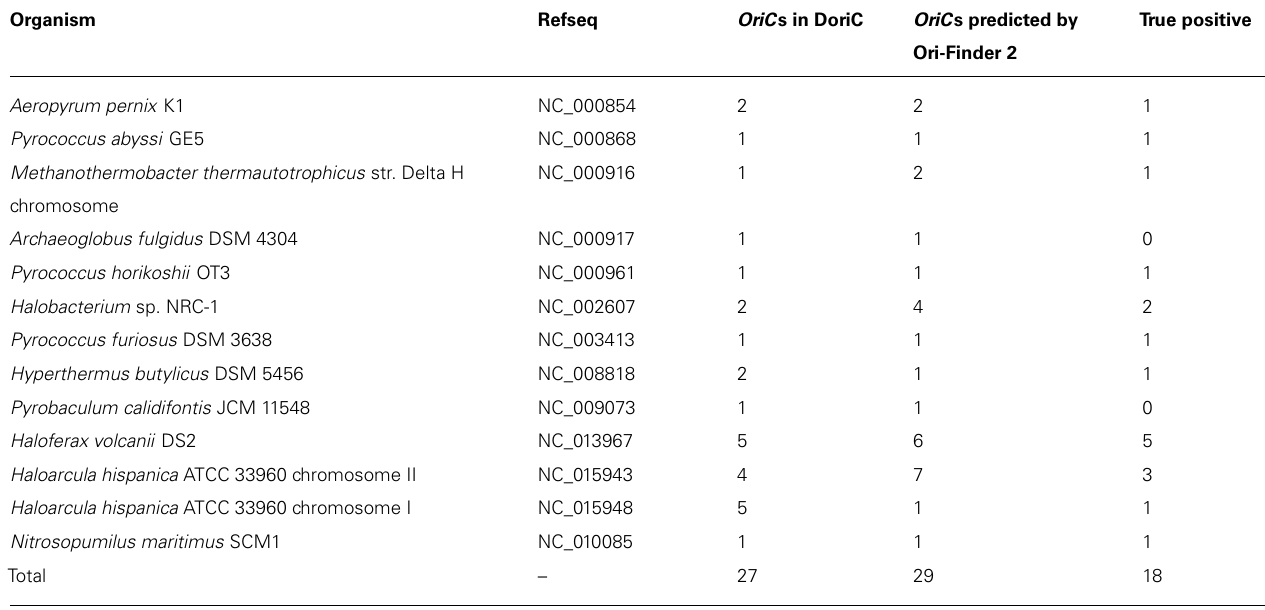
Table 2 |The prediction results of 13 archaeal chromosomes a